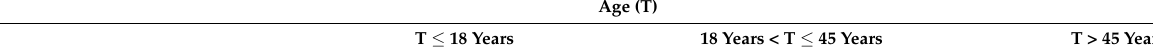
Developing countries